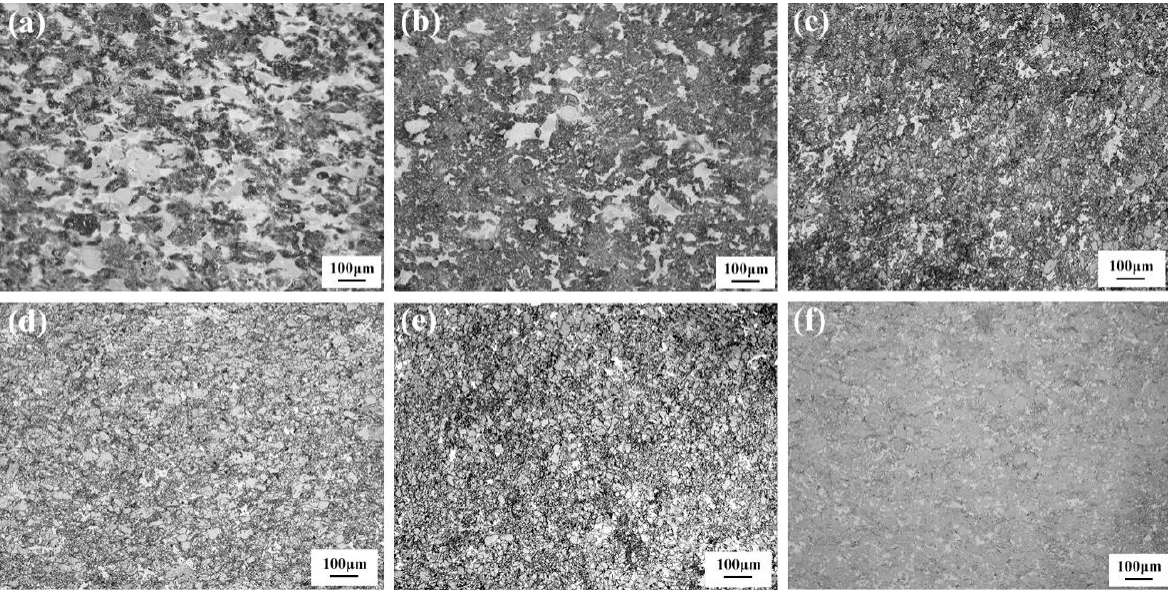
Figure 2. Microstructure of sintered matrixes with different Ni content. ( a ) Ni-free; ( b ) with 3. wt.% Ni; ( c ) with 6 wt.% Ni; ( d ) with 9 wt.% Ni; ( e ) with 12 wt.% Ni; ( f ) with 15 wt.% Ni.